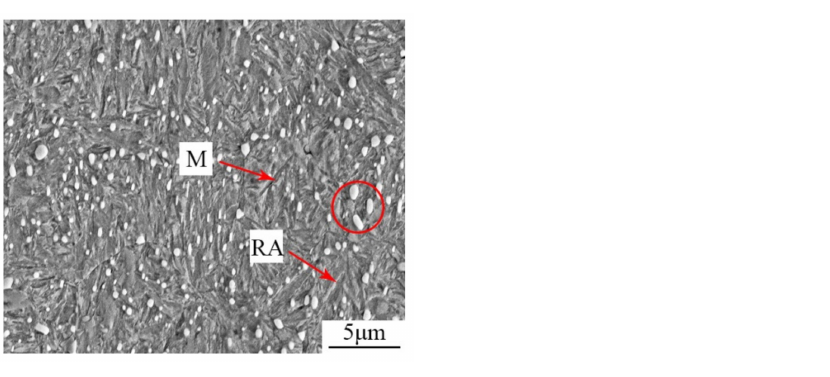
Figure 5. SEM images of the steel after oil quenching and tempering process. Notes: M—martensite, RA—retained